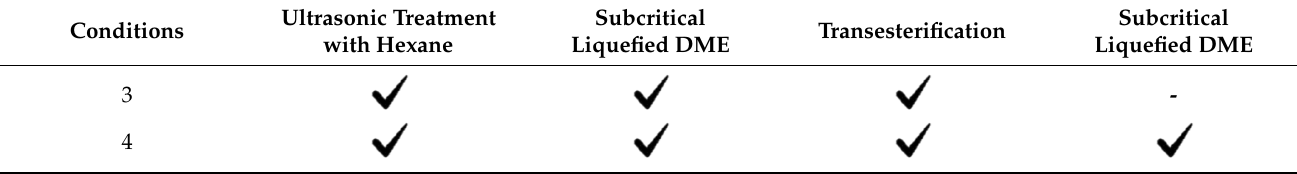
Table 1. Conditions for policosanol extraction of filter mud.